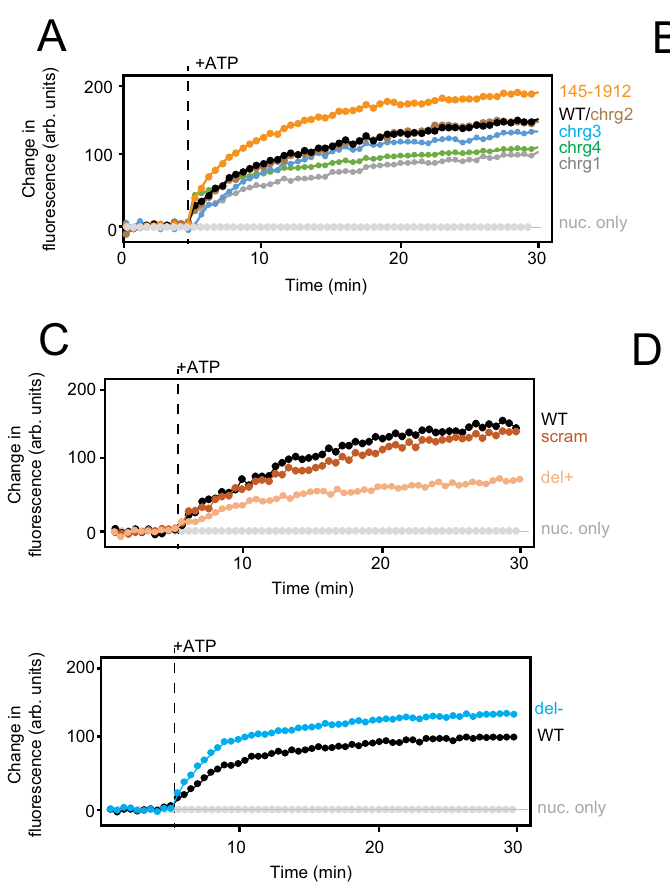
Fig. 3 | The intrinsically disordered regions (IDRs) in the N-terminal part of CHD4 are important for remodelling. A RTFA data for the IDR1 charge mutants, alongwithamutantin whichresidues 1 – 144weredeleted. B Numbersofpositively or negatively charged residues, as well as polar residues, in the del+ and del – mutants. C RTFAdataforIDR2mutantsinwhichthesequence ofresidues227 – 362 was either scrambled (scram) or depleted of either positively charged residues (del+)ornegativelychargedresidues(del – ).We note thatthedel – curve (whichis